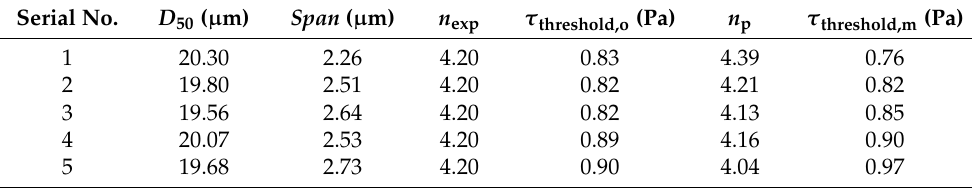
Table 2. The modified powder fitting coefficient n and yield stress threshold. Serial No.